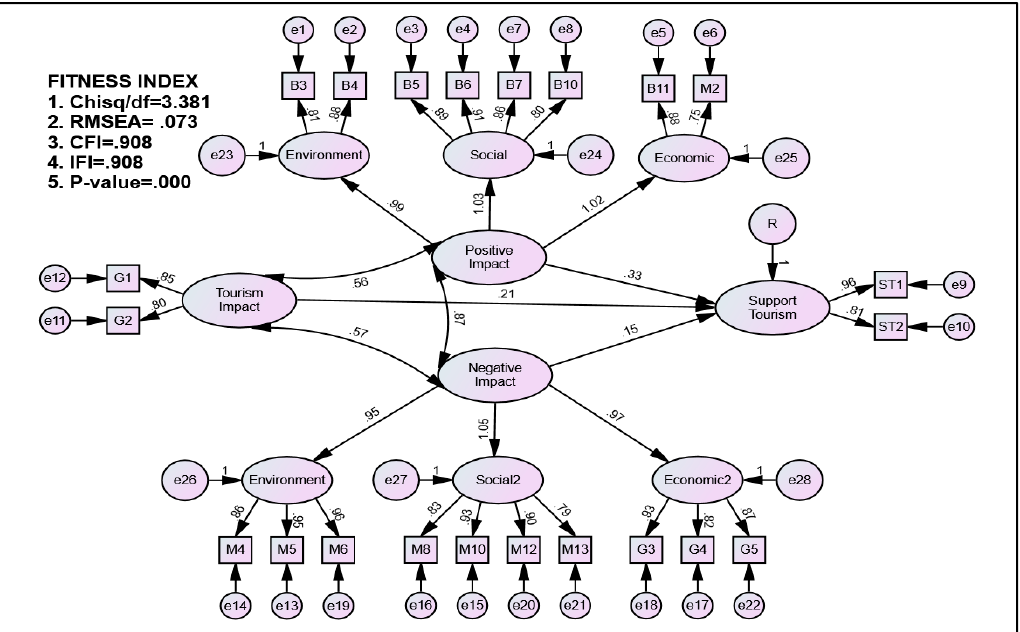
Figure 3. Structural model. Table 3. Regression weights.